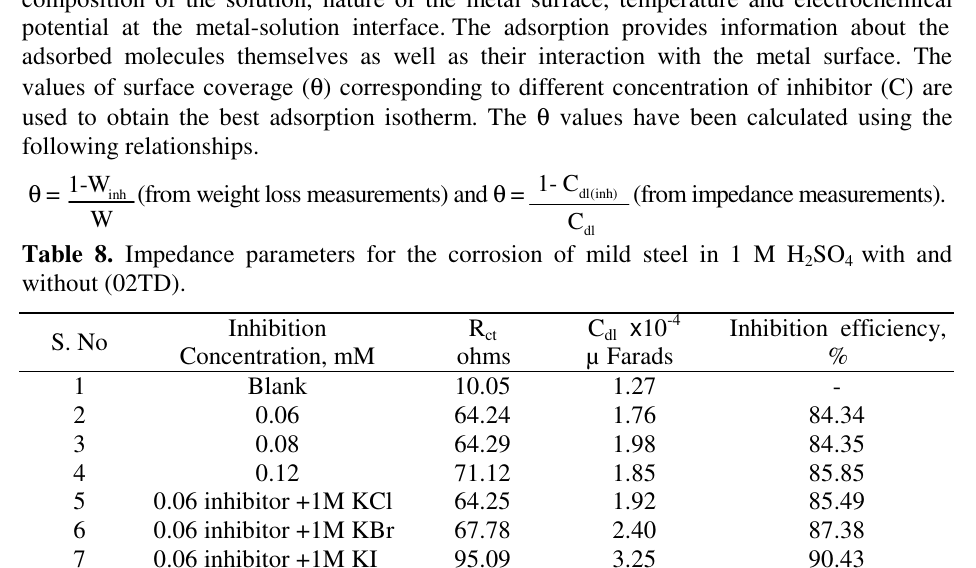
SO with and 2 4